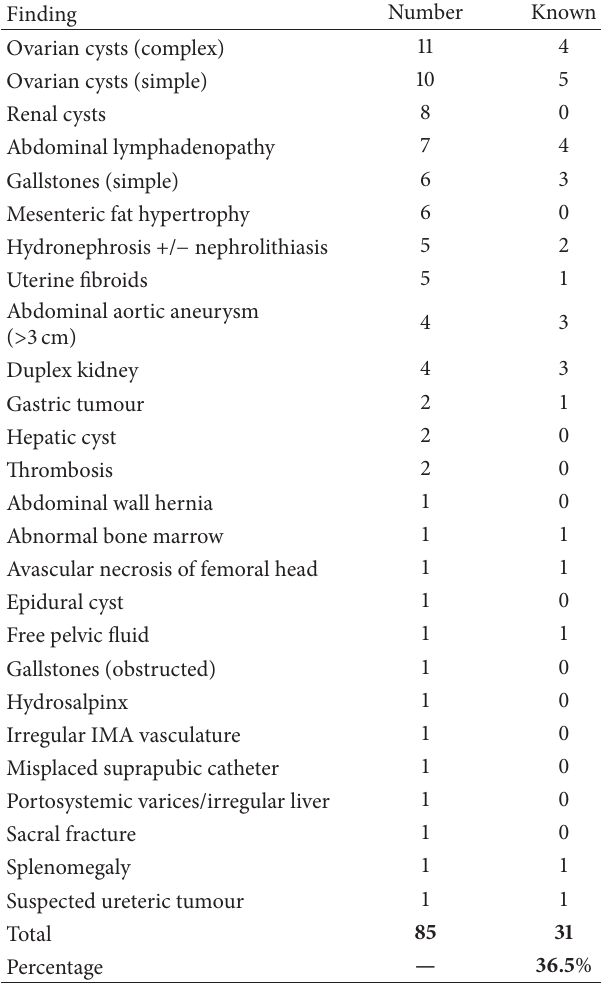
Table 2: Extraenteric findings in order of frequency.